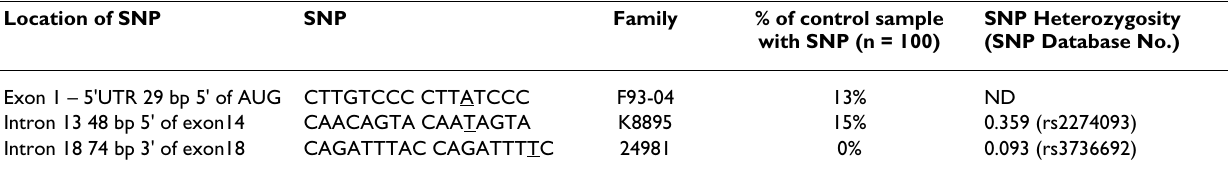
Table 1: Mutation analysis of 12 families linked to Xq25 revealed 3 SNPs Location of SNP SNP Family % of control sample